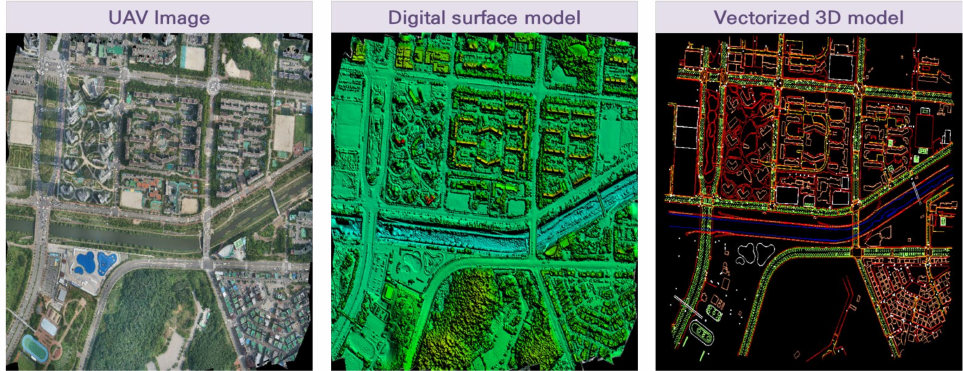
Figure 7. Ortho-rectified image ( left ), digital surface model ( middle ), and 3D model ( right ) obtained by UAV.